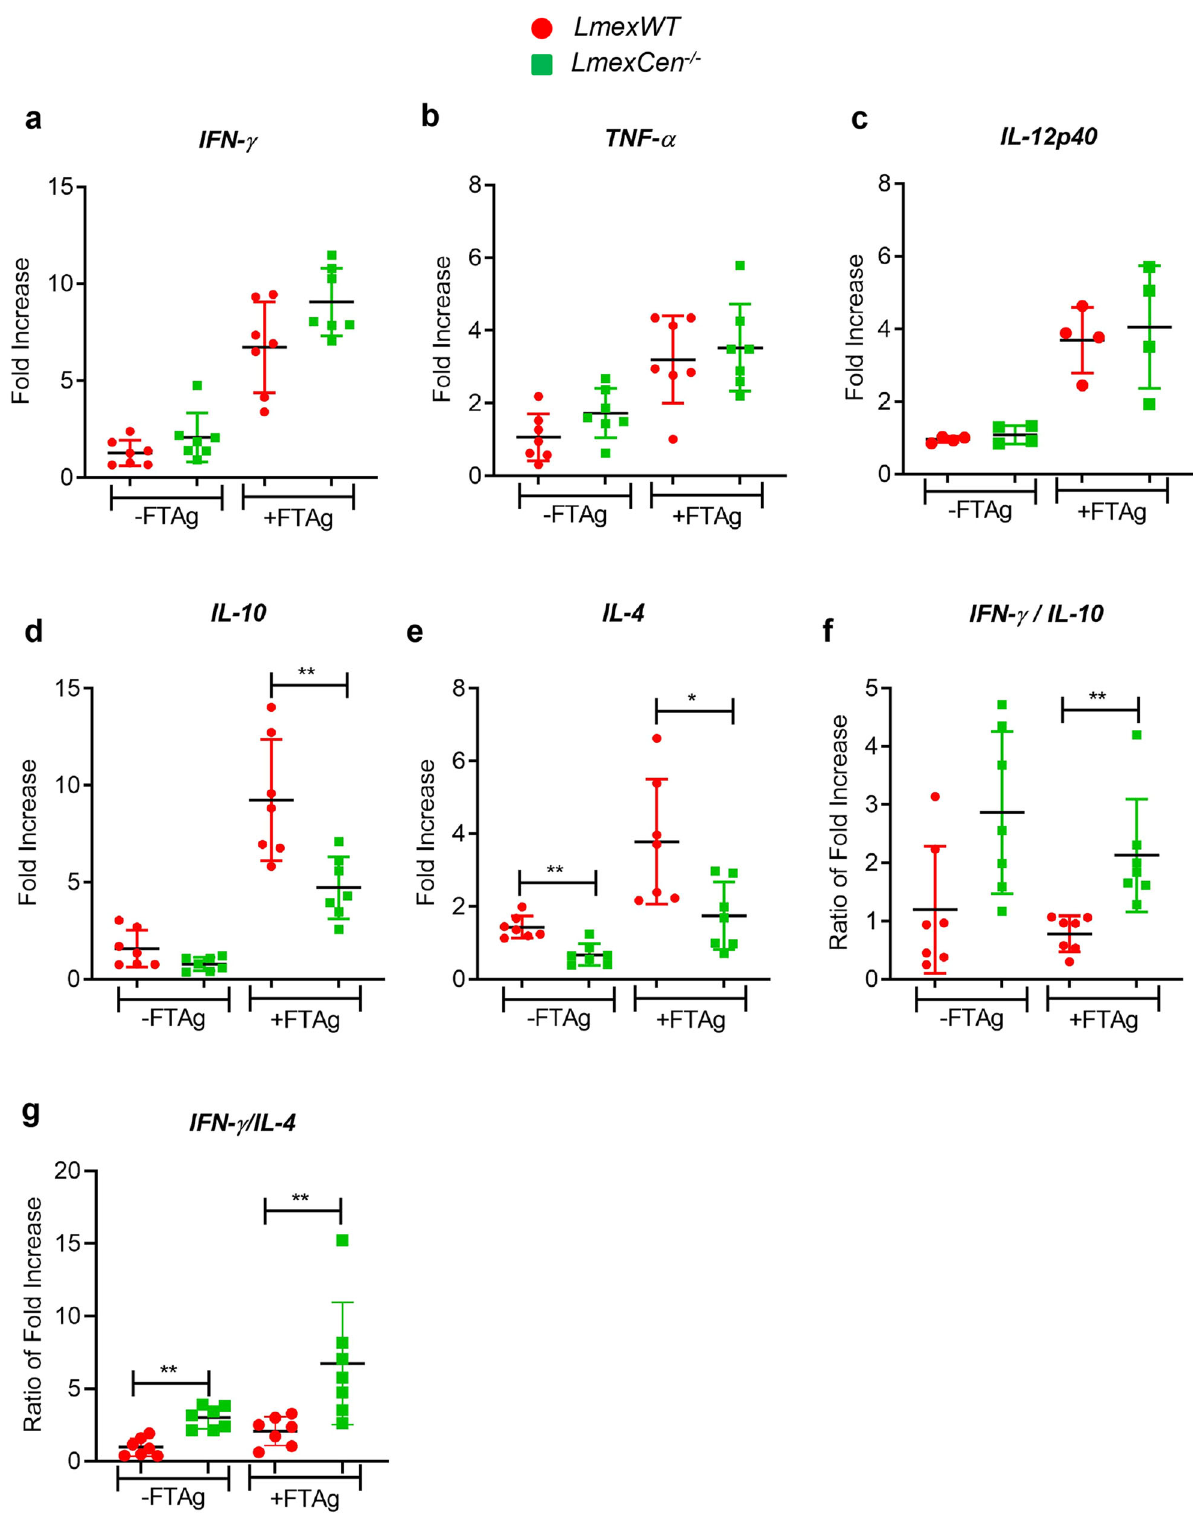
Fig. 2 Live attenuated LmexCen − / − parasites down regulate disease promoting cytokines expression in spleen of hamsters. a IFN- γ , b TNF- α , c IL-12p40, d IL-10, and e IL-4 expression in the spleen of LmexWT or LmexCen − / − inoculated hamsters was evaluated by RT-PCR following 11 weeks post-inoculation. The ratio of IFN- γ /IL-10 ( f ) and IFN- γ /IL-4 ( g ) expression in the spleen was also determined. Except IL- 12p40, results (mean ± SD) are cumulative of two independent experiments; in fi rst experiment n = 4/group and in second experiment n = 3/ group. Statistical analysis was performed by Mann – Whitney two-tailed test (* p = 0.0175, and ** p =